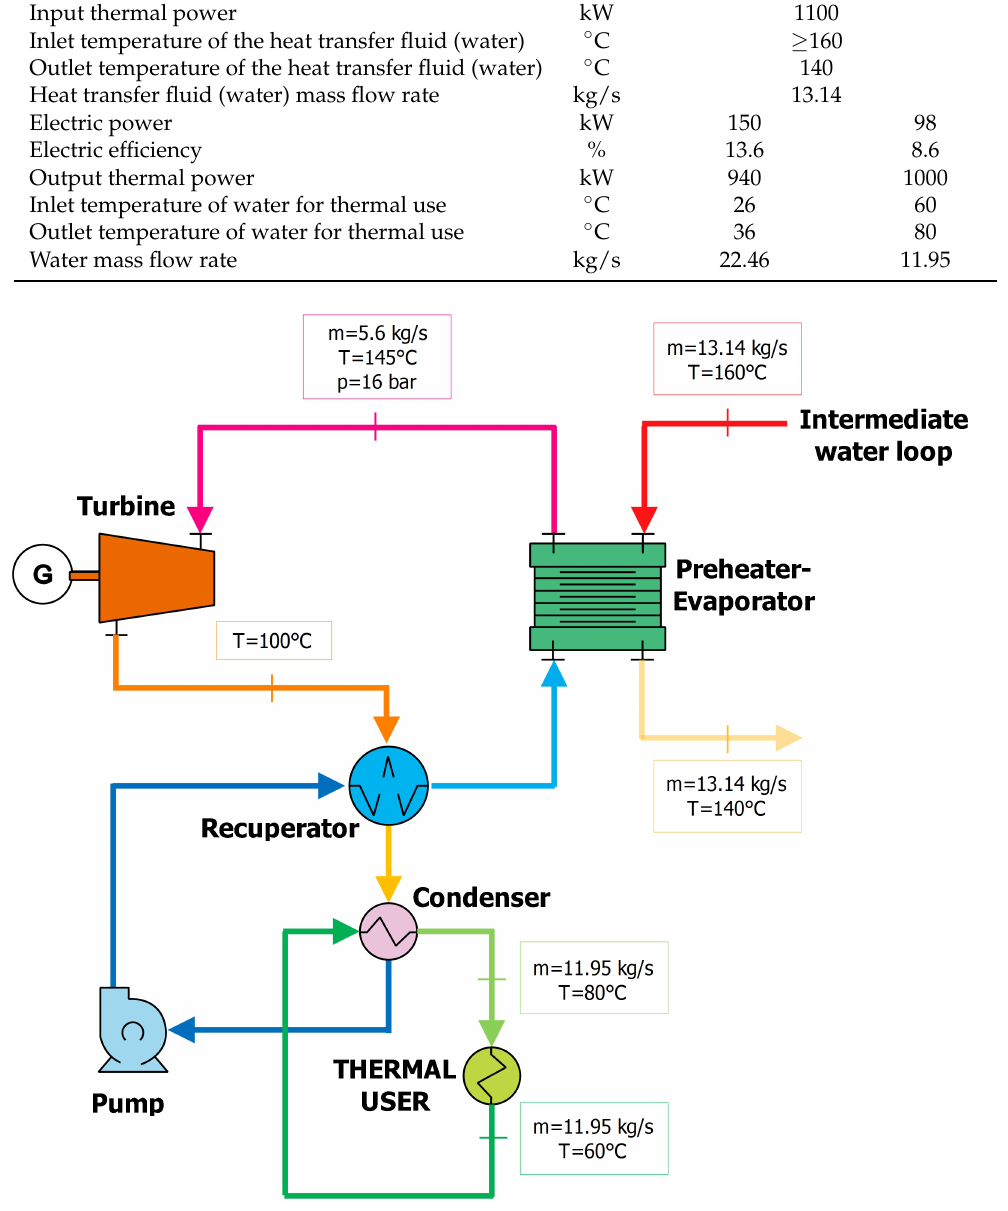
Figure 1. Schematic view of the ORC unit in its Combined Heat and Power (CHP) operation. Data refer to design point operating